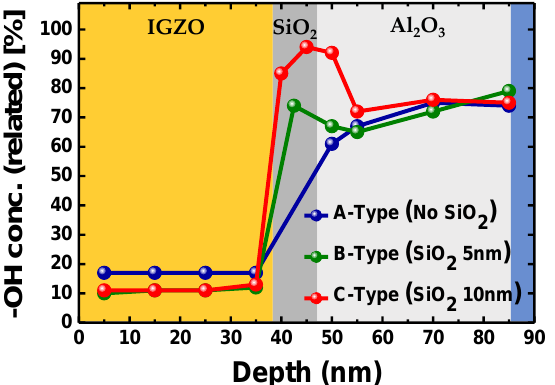
Figure 3. Illustration of hydrogen movement in the Al 2 O 3 , SiO 2 layer during the gate insulator deposition. ( a ) Schematic view of the IGZO synaptic TFTs with hydrogen movement by deposition process. O 1 s XPS spectra of Al 2 O 3 layer in ( b ) B-type and ( c ) C-type IGZO synaptic TFTs in the SiO 2 layer. O 1 s XPS spectra of Al 2 O 3 layer in ( d ) A-type, ( e ) B-type, and ( f ) C-type IGZO synaptic TFTs in Al 2 O 3 layer.